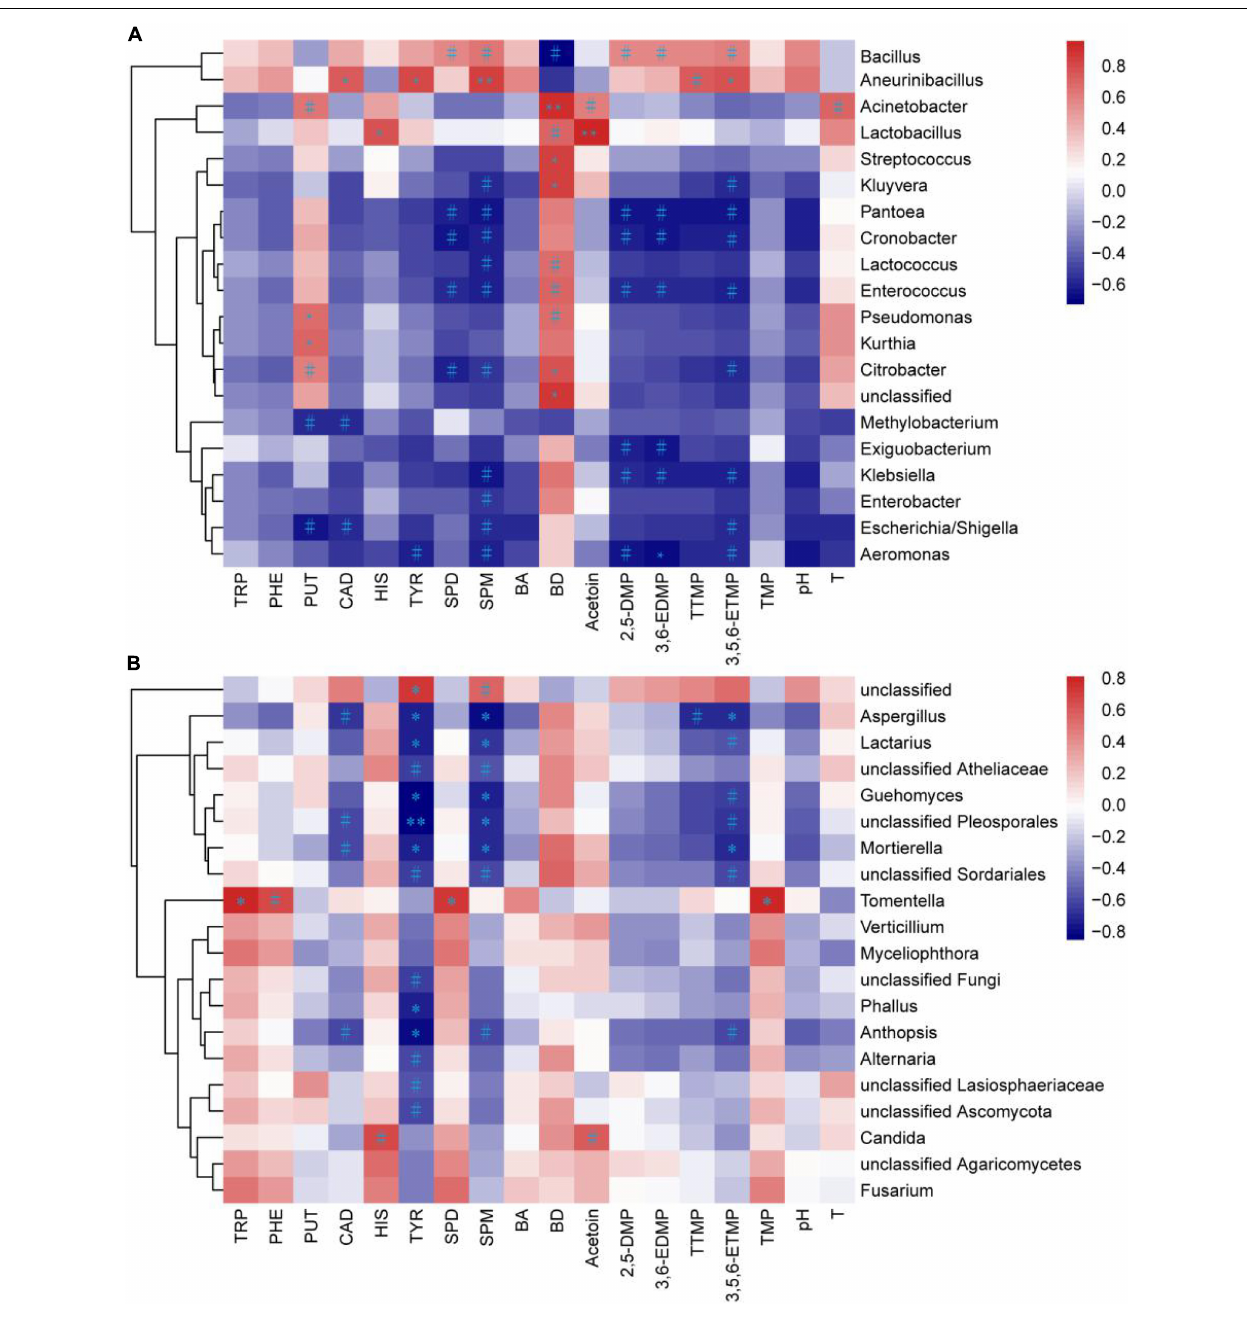
FIGURE 5 | Heatmap of the correlations between the microbiota and chemical characteristics in the non-post fermented Shuidouchi samples. The Pearson correlation coefficient r in the bacterial (A) and fungal (B) communities ranged from –1 to 1; positive correlation was r > 0, and the negative correlation was r < 0, where # represents p < 0.1, ∗ represents p < 0.05 and ∗∗ represents p < 0.01, and T, temperature; BA, total biogenic amine concentration; BD,